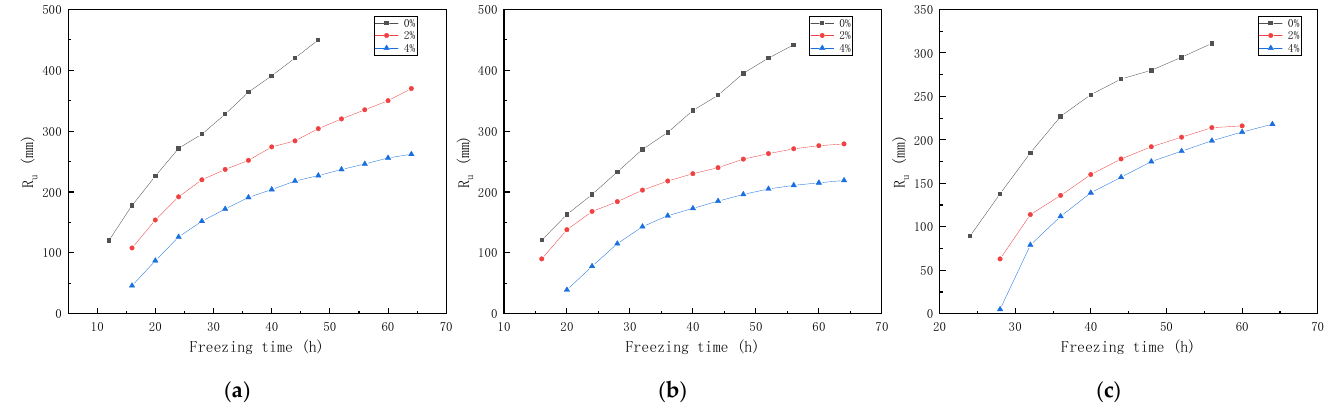
Figure 13. The developments of R u at ( a ) 0 m/d; ( b ) 3 m/d; ( c ) 6 m/d.